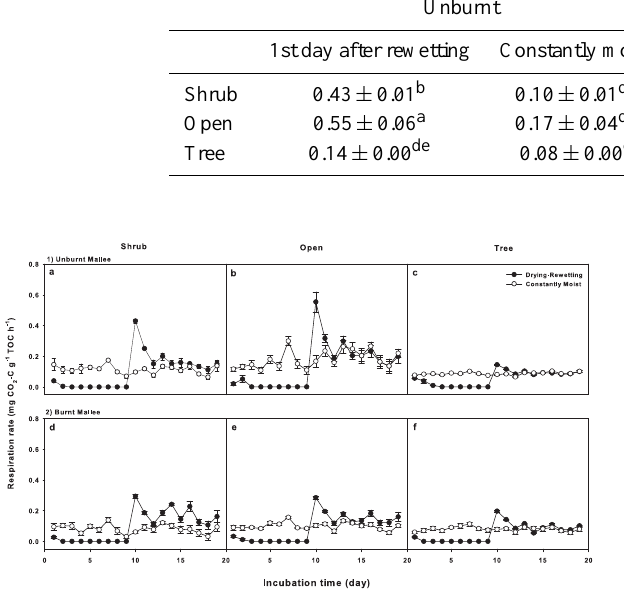
Table 2. Soil respiration rate per gram of TOC and hour on day 1 after rewetting and that under the constantly treatment (mean ± standard error, n = 4). Different letters indicate significant differences at p <0.05 for the three-way interaction patch × burning × moisture treatment. Patch